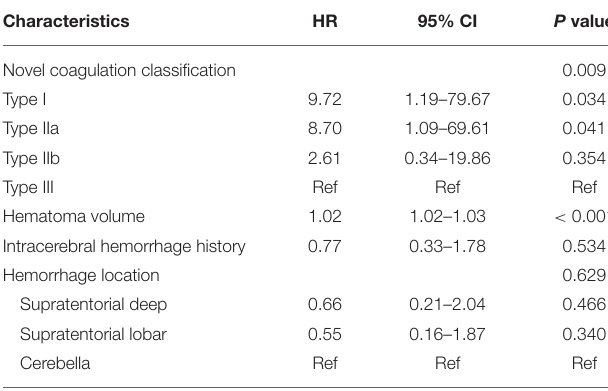
TABLE 3 | Multivariate Cox regression analyses for risk factors related to the PR.